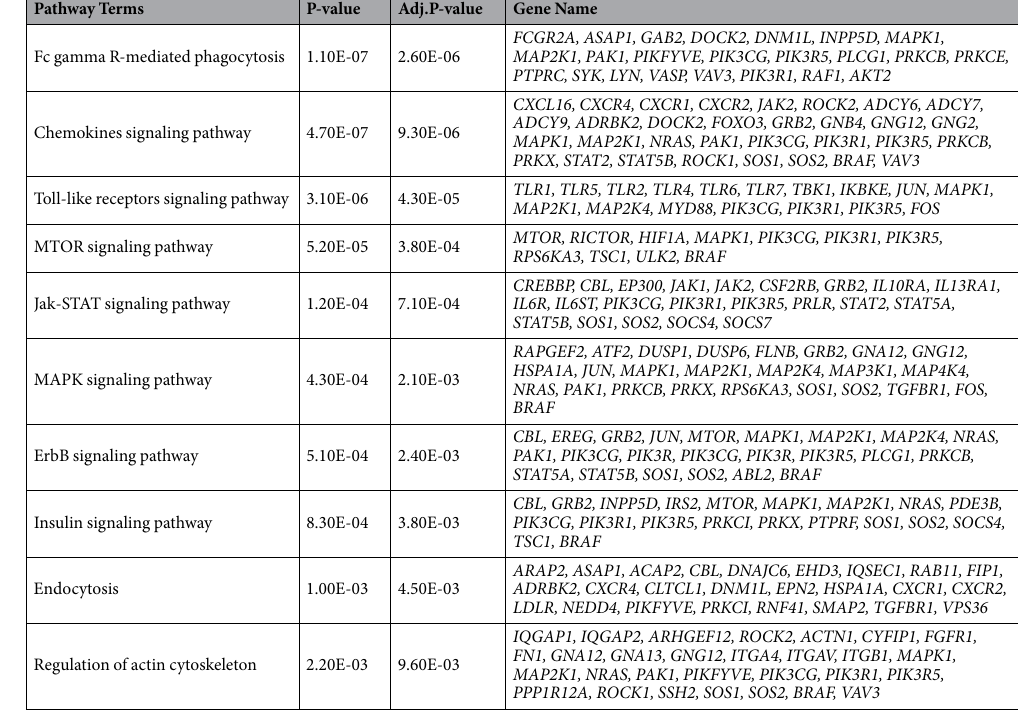
Table 3. The downregulated genes involved in immune-related pathways in primary monocytes of XLA patients compared to healthy